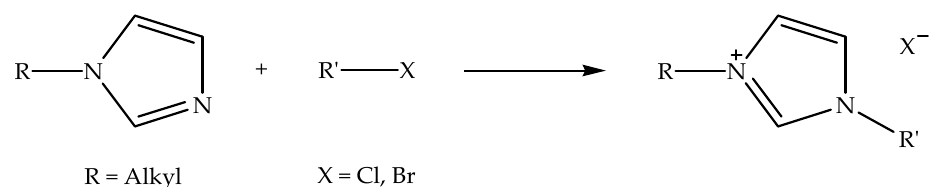
Figure 2. Schematic of the alkylation reaction of N -alkylimidazole with alkyl halide to prepare alkylimidazolium halide ionic liquid.